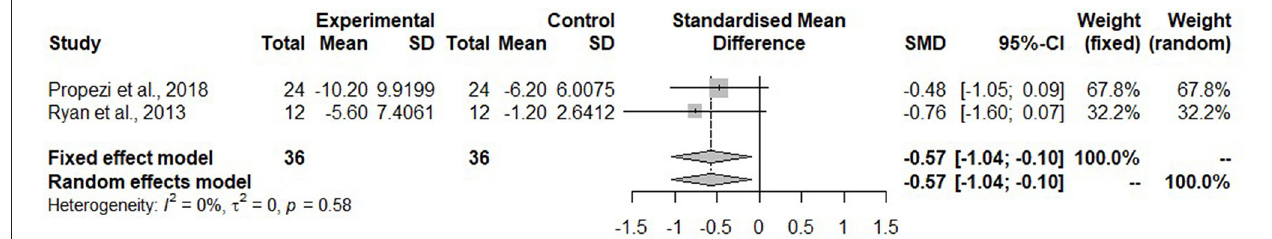
− 9.09 ± 12.8 IU/L, p = 0.020; control: − 8.91 ± 10.0 IU/L, Glucose